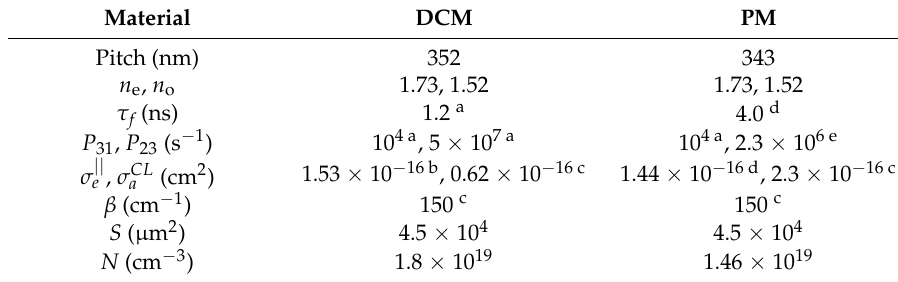
Table 5. Parameters used for the simulations. The pumping wavelength was 532 nm and the laser emission wavelengths were 605 nm and 590 nm for the materials with dyes DCM and PM597 respectively. σ CL a is the absorption cross-section for the pumping